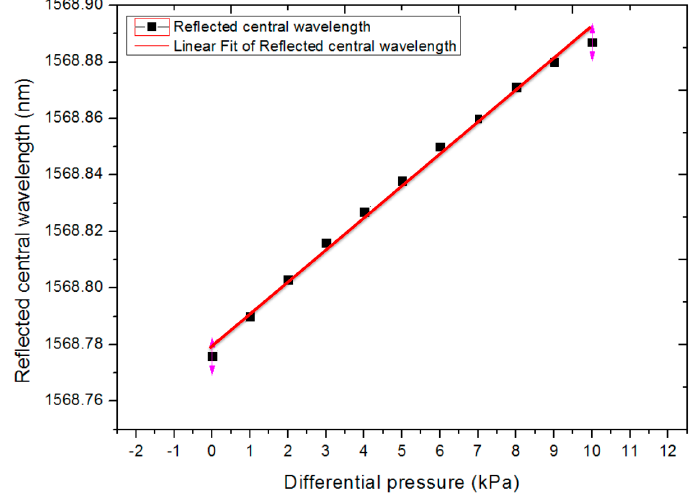
Figure 10. The differential pressure sensor linearity curve.